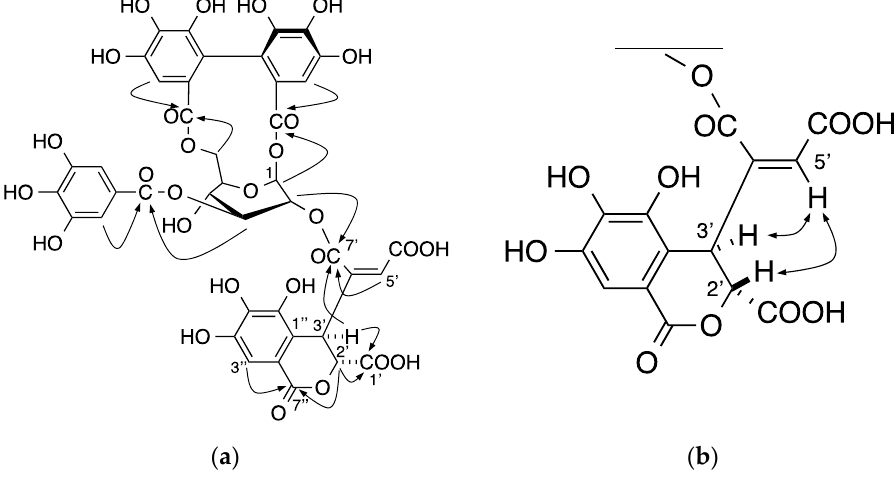
Figure 2. Key HMBC ( a ) and ROESY ( b ) correlations of davicratinic acid A ( 5 ).